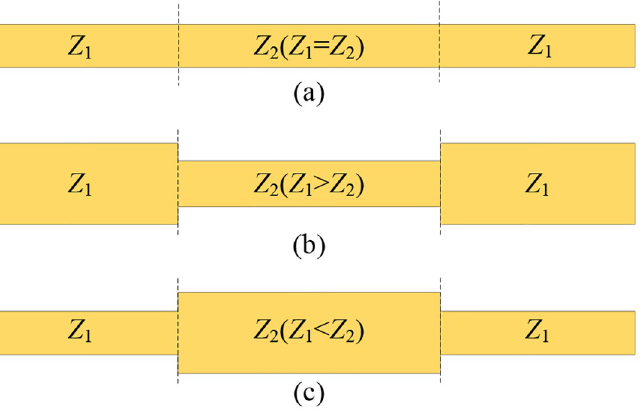
Fig 2. Half-wavelength open transmission line resonator with impedance ratio K . (a) K = 1; (b) K < 1; (c) K > 1.